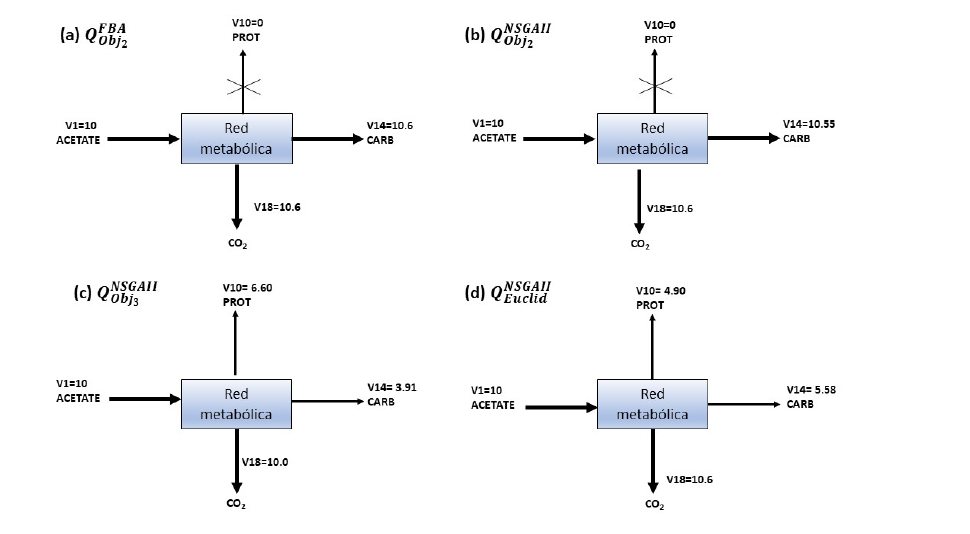
Figure 6. The distribution fluxes of objective function. Subfigure ( a ) shows the optimization of the v 14 flux using FBA; subfigures ( b – d ) correspond to different fluxes distributions obtained from NSGAII optimizing v 14 , v 10 and v 18 simultaneously.